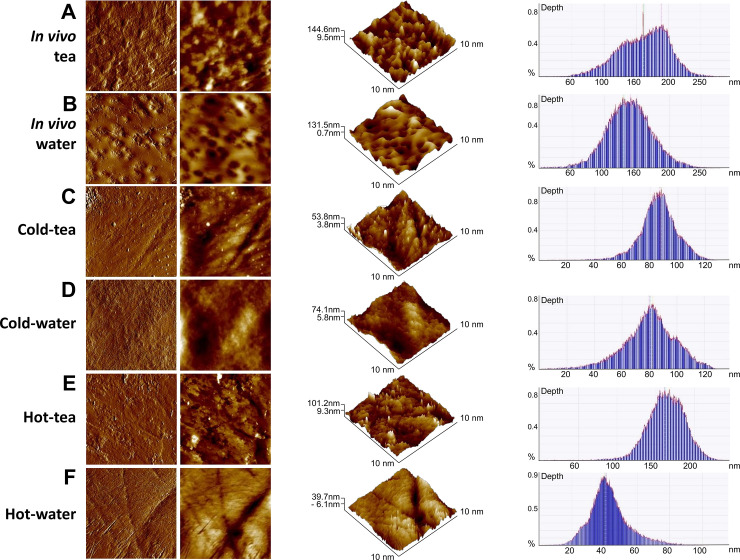
Atomic force microscopy identified loss of roughness on enamel surface induced by high temperature.Representative topographic cleared and flatten images of enamel surface (two columns at the left); three-dimensional images (middle) and depth histograms (right) from in vivo (A-B), and in vitro groups (C-F). (A) Enamel of teeth from the in vivo tea group showed considerable roughness. (B) The in vivo control group treated with water had slightly reduced enamel roughness compared to tea. (C) Cold-tea group showed a surface with the appearance of aggregates on the enamel, not seen in the cold-water treatment (D). (E) Hot-tea showed aggregates over the enamel not seen from hot-water group (F). Images were obtained from an 10x10 μm2 area (N = 3 jaws, N = 24 teeth per group).